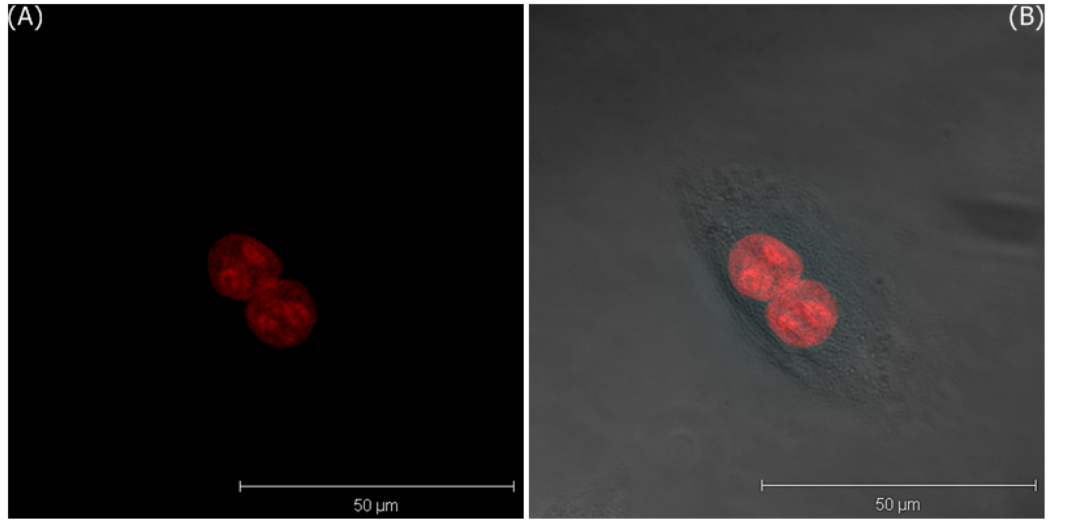
Figure 5. The 3D projection images of MDA-MB-435S cells incubated with bare GNPs in media after 5 minutes; A) LSCM image, and B) the merged image of LSCM and the phase contrast